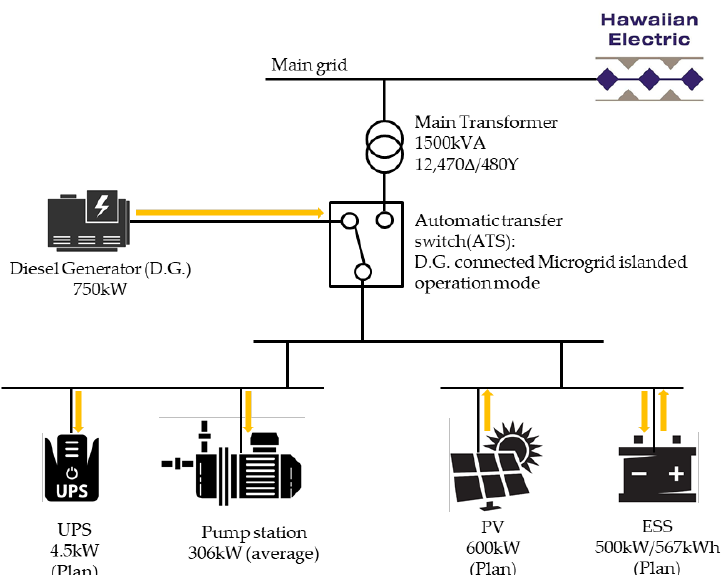
Figure 2. NELHA Microgrid configuration (the photovoltaic (PV), the energy storage system (ESS), and Uninterruptible Power Supply system (UPS) are planned to be installed) [5].